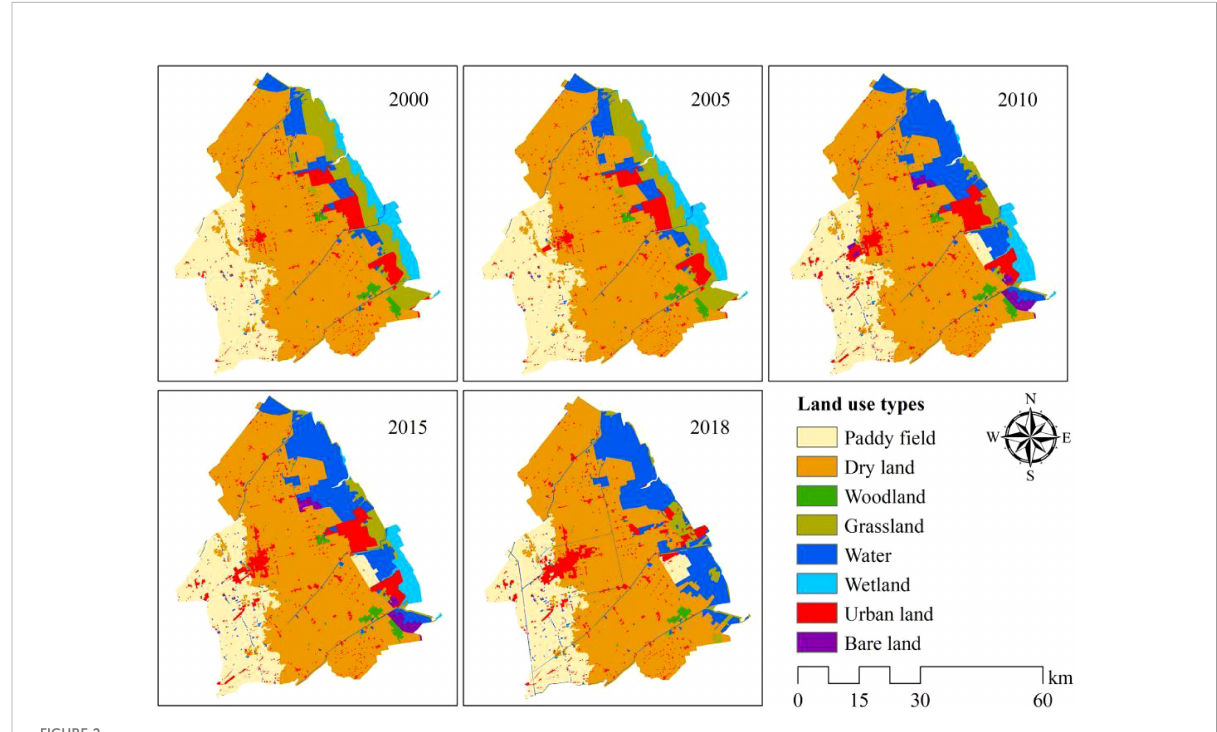
FIGURE 2 Landscape classi fi cation of Dafeng (2000 – 2018).